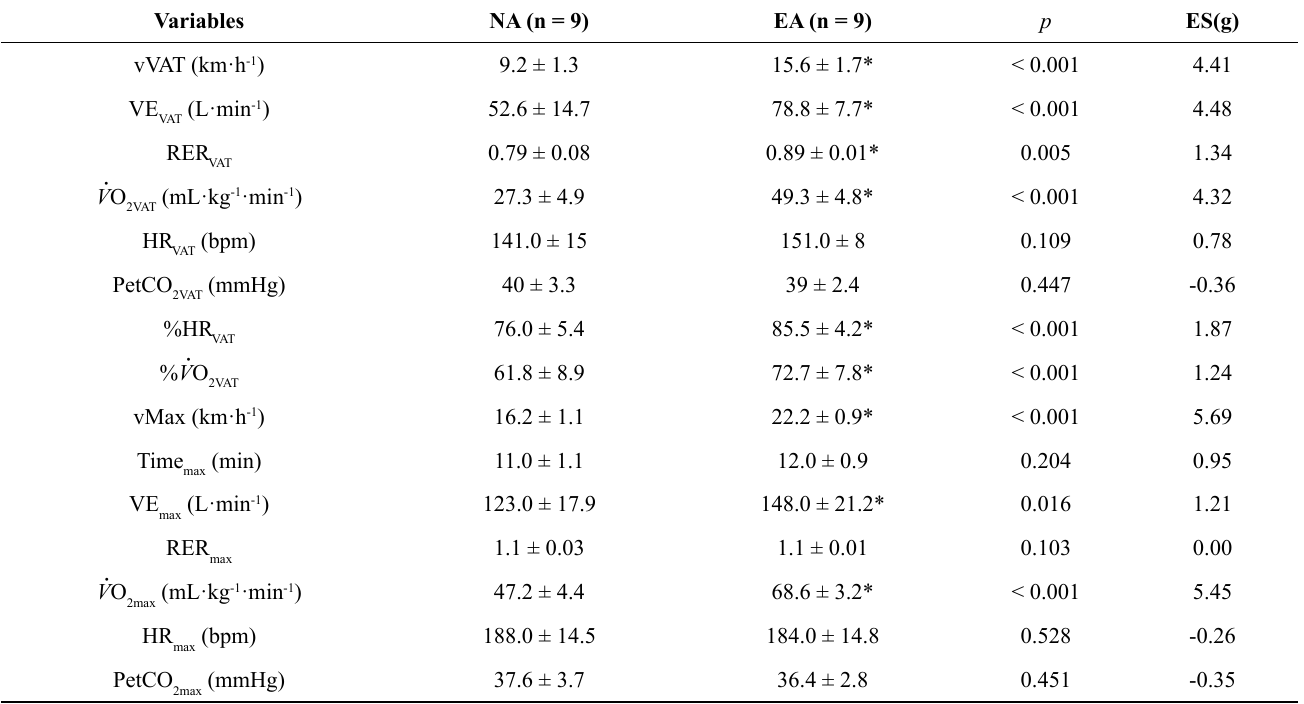
Table 2 – Speed, metabolic and ventilatory variables of CPx regarding vVAT.